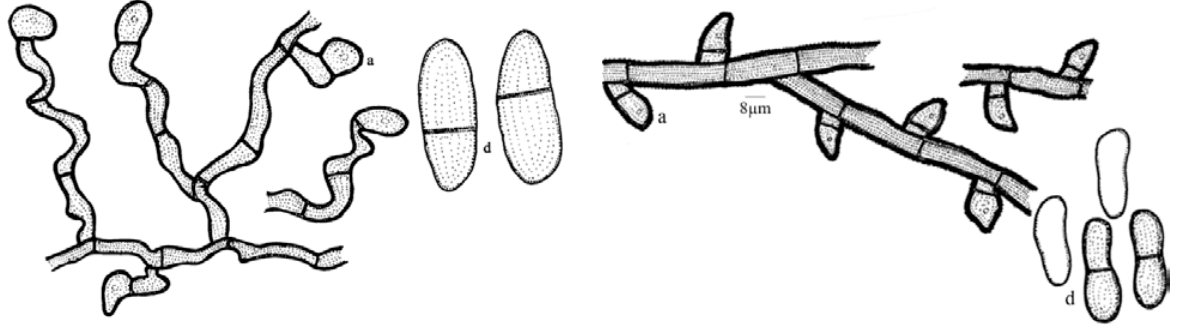
Figure 9. Armatella balakrishnanii a - Appressoriate mycelium; d - Ascospores